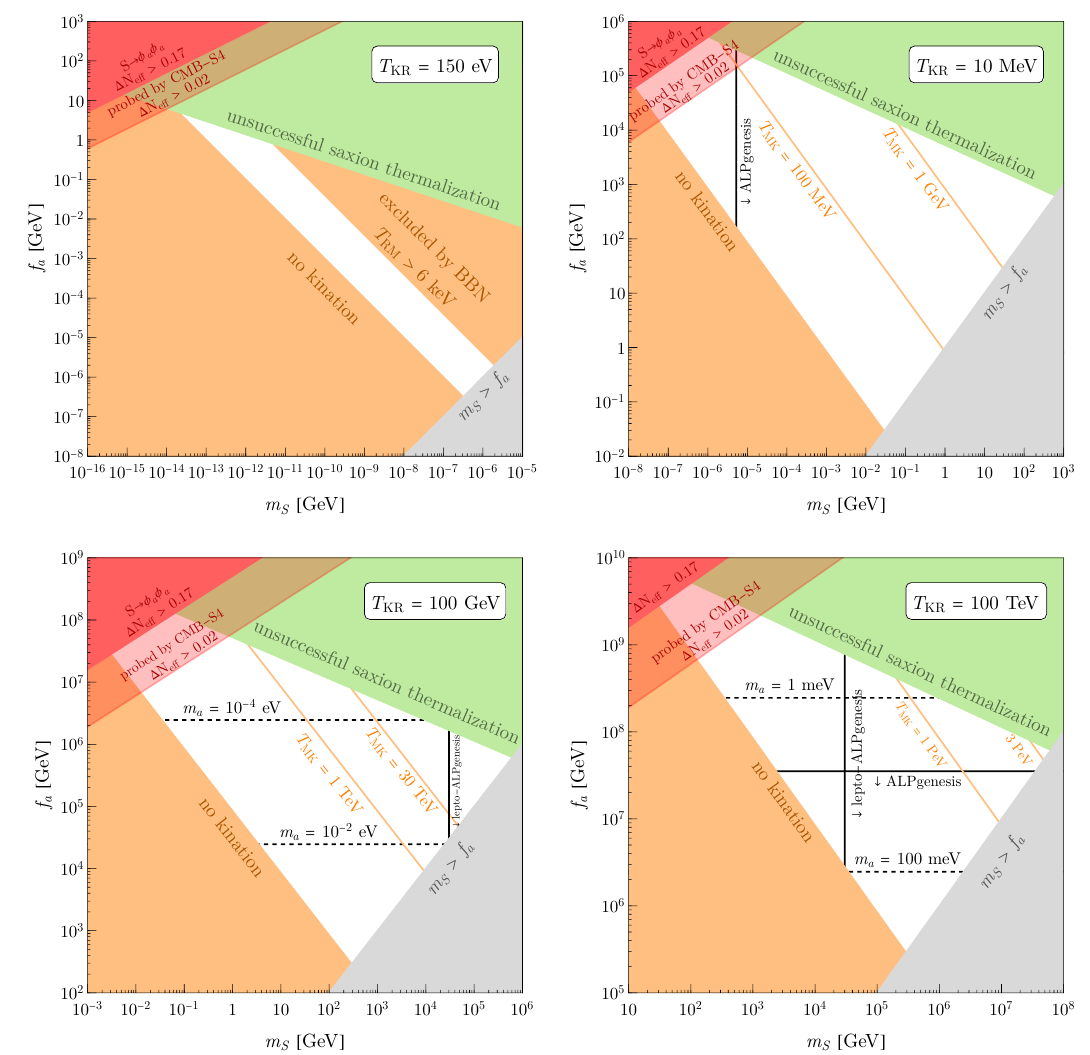
Figure 6 . The unshaded regions show the allowed parameter space for axion kination for the fixed values of T KR labeled in each panel. Contours of T MK are shown in these regions with kination. The excluded shaded regions are discussed in the text. To achieve minimal ALPgenesis, the parameter space collapses into m S ’ 5 keV(0 . 1 /c B ) as shown by the black solid line in the upper-right panel, or into f a given by eq. (4.8) with S ( T ws ) = f a as shown by the black solid line in the lower-right panel, where we take c B = 0 . 1 . On the other hand, lepto-ALPgenesis restricts the parameter space to m S & 30 TeV . The axion cannot constitute dark matter via kinetic misalignment in the upper panels due to the warmness constraint in eq.